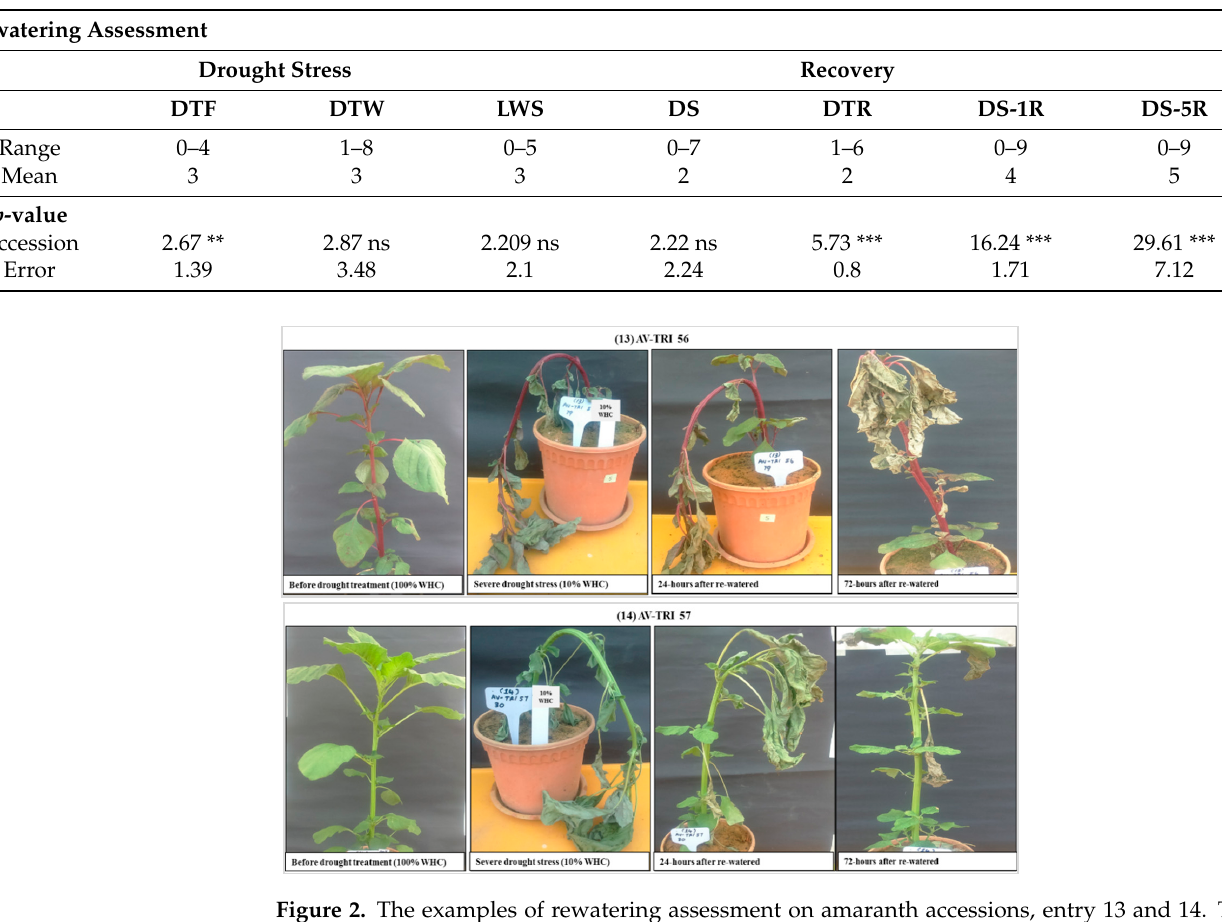
Figure 2. The examples of rewatering assessment on amaranth accessions, entry 13 and 14. The images were captured (i) a day before the imposition of drought stress (100% WHC), (ii) at terminal